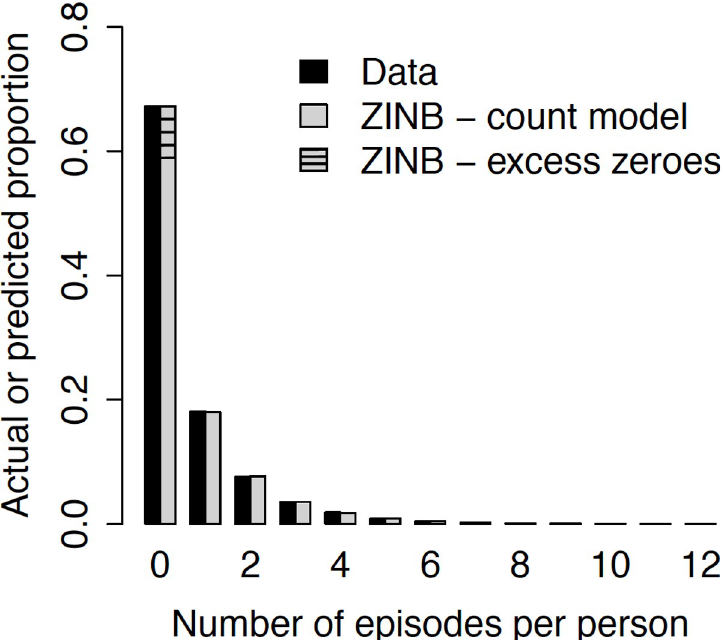
Fig 2. Zero-inflated negative binomial (ZINB) model fit to malaria episode counts per person in urban Maˆncio Lima, northwestern